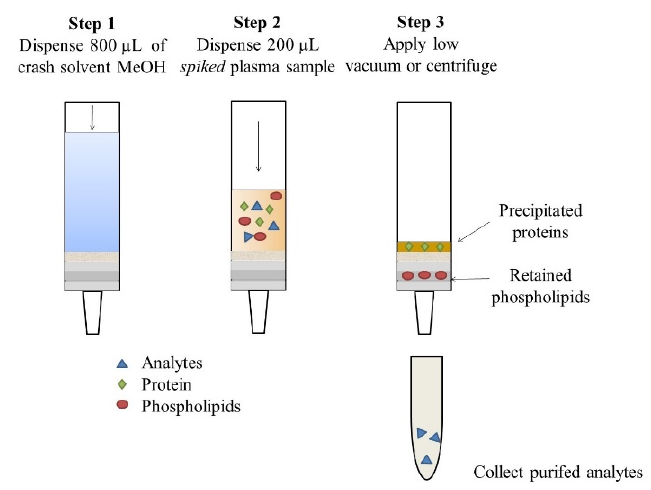
Figure 2. The schematic diagram for the SPE procedure using Isolute ® PLD+ and Phree Phosfolipide removal